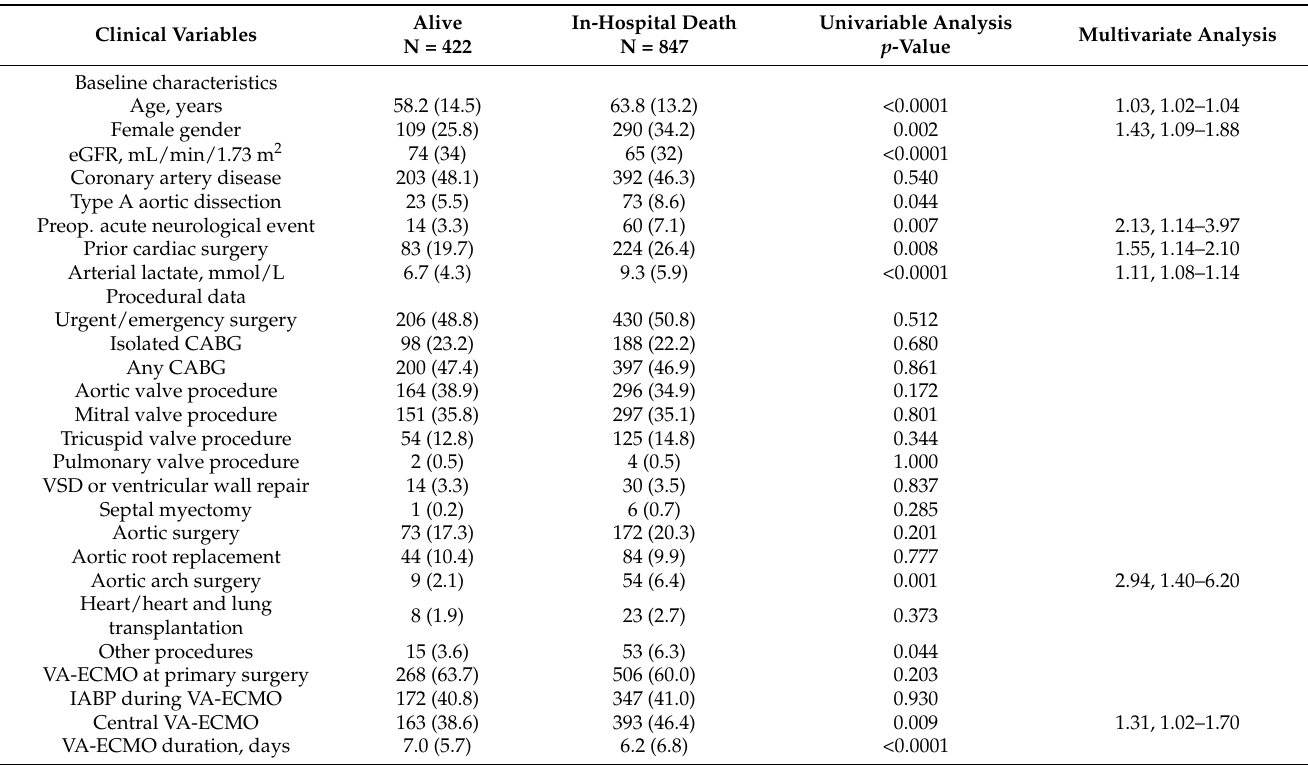
Clinical Variables